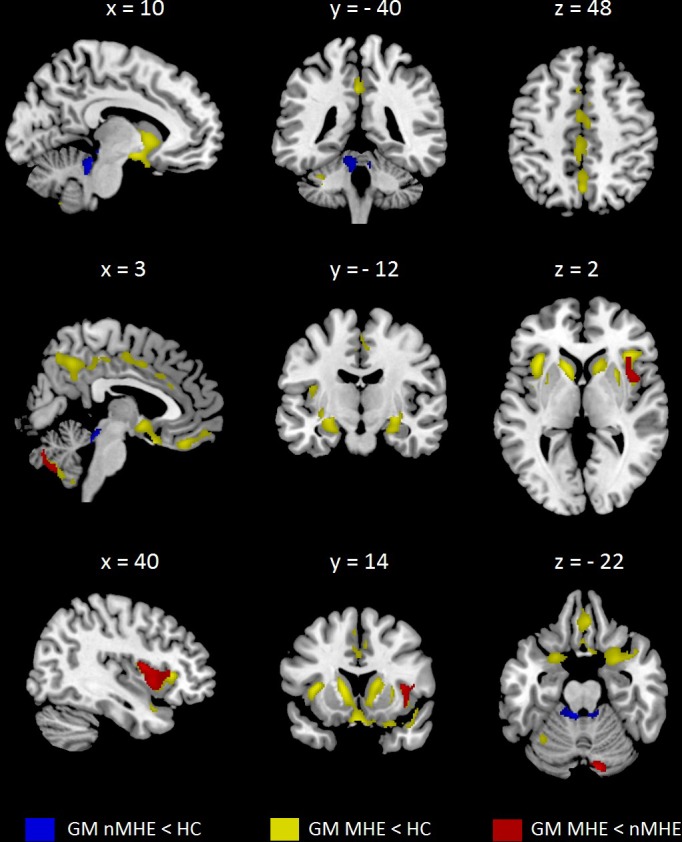
Localization of gray matter atrophy between groups including gender as nuisance covariate.All results were assessed at p<0.05 FWE cluster-corrected for the multiple comparisons in a combination with a threshold of p<0.001 at the uncorrected voxel level. HC, Healthy Controls; nMHE, patients without Minimal Hepatic Encephalopathy; MHE, patients with Minimal Hepatic Encephalopathy; GM, Gray Matter. Images are in neurological convention.